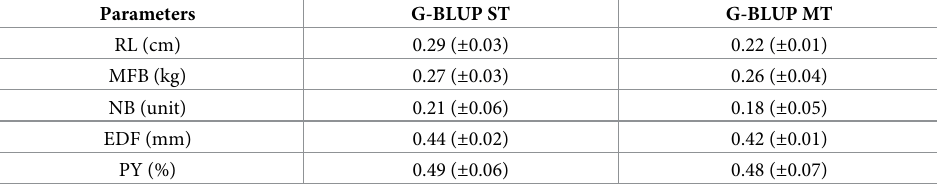
Table 3. Predictive ability for G-BLUP ST and G-BLUP MT. Predictive ability ( r